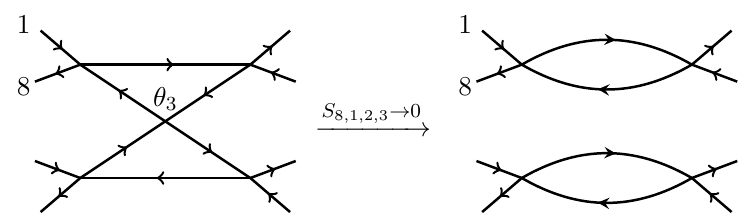
Figure 6. The diagram shows the S 8 , 1 , 2 , 3 → 0 limit for an eight-point diagram, where the diagram separates into two reducible bubbles, therefore it is a co-dimension three boundaries.